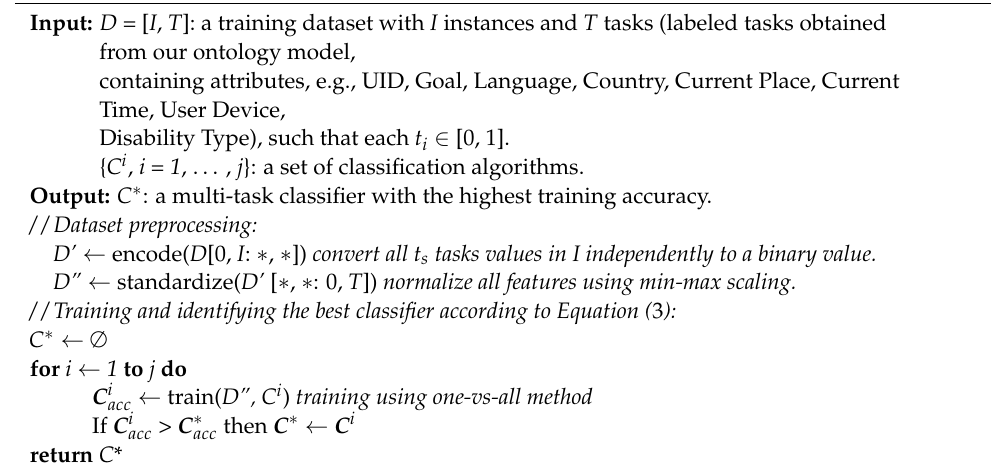
Algorithm 2: Validation procedure to predict a set of tasks, T , using C ∗ classifier for each disabled user. Input: C ∗ : a multi-task classifier with the highest training accuracy, obtained by Algorithm 1. V I × N : a validation dataset containing I examples with N input features. θ : a predefined probability threshold with a default setting of θ = 0.5. Output: O I ×| T | : a set of predicted tasks (ontological atomic tasks) for all users, I. V ← preprocessing(V I × N ) / / preprocessing the validation dataset as shown in Algorithm 1 . O ← C ∗ .predict(V) for j ← 1 to I do If O [ j,k ] > θ then O [ j.k ] ← 1 : O [ j.k ] ← 0 return O